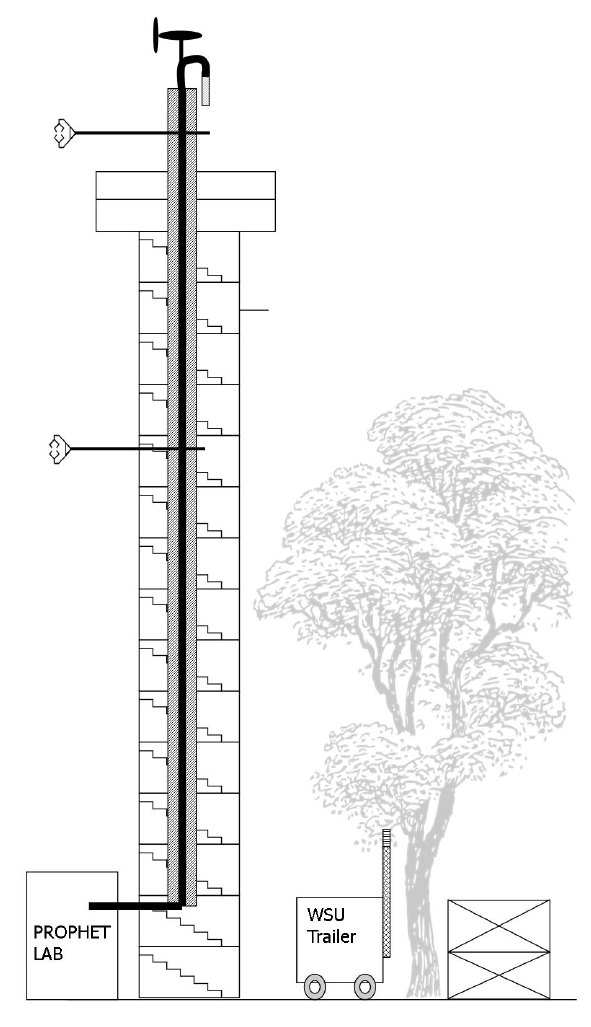
Fig. 1. University of Michigan Biological Station (UMBS) PROPHET tower schematic as configured for CABINEX